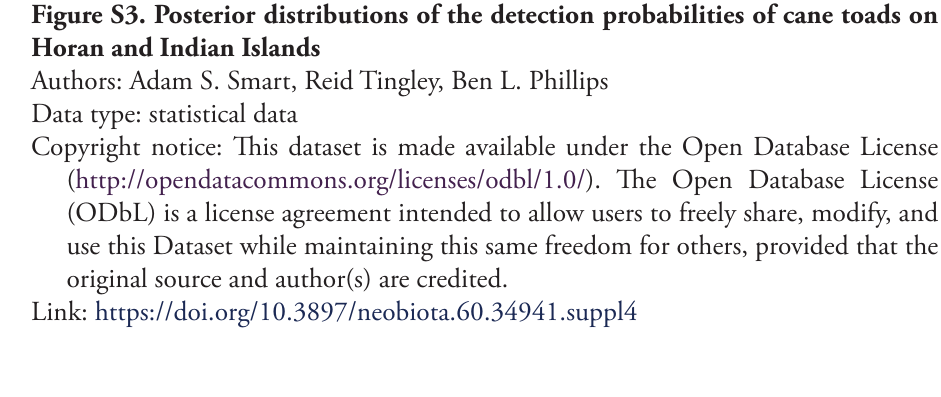
Figure S3. Posterior distributions of the detection probabilities of cane toads on Horan and Indian Islands